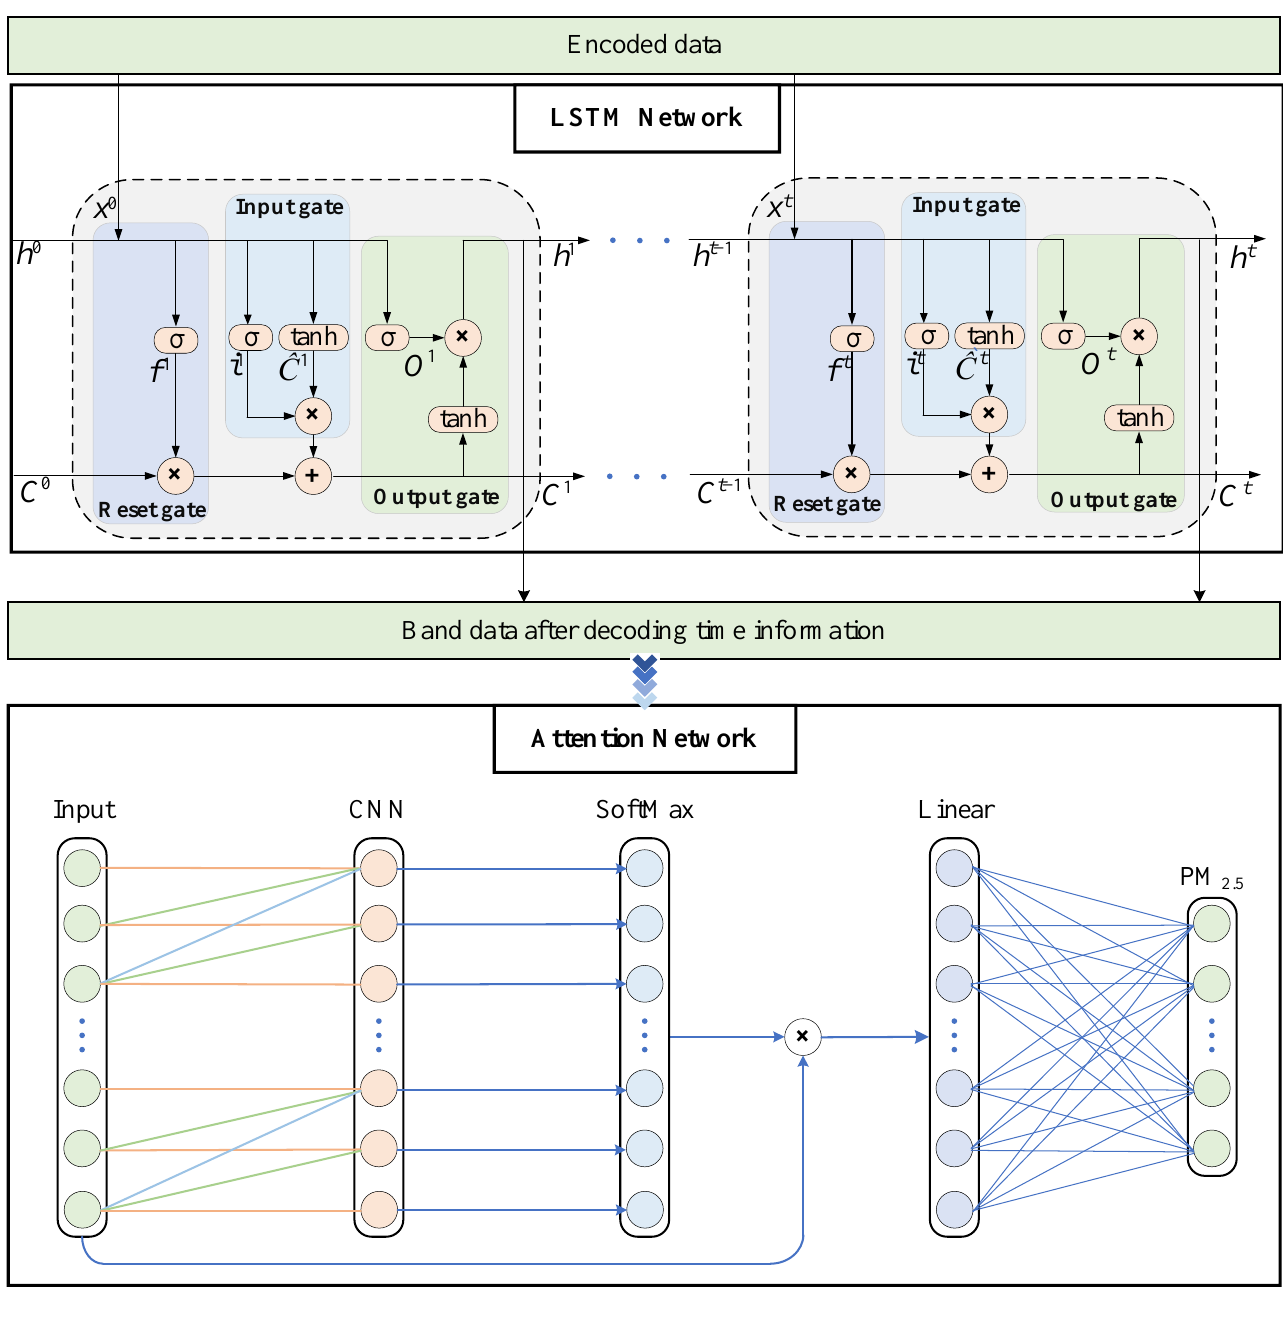
Figure 8. Structure of the decoder.